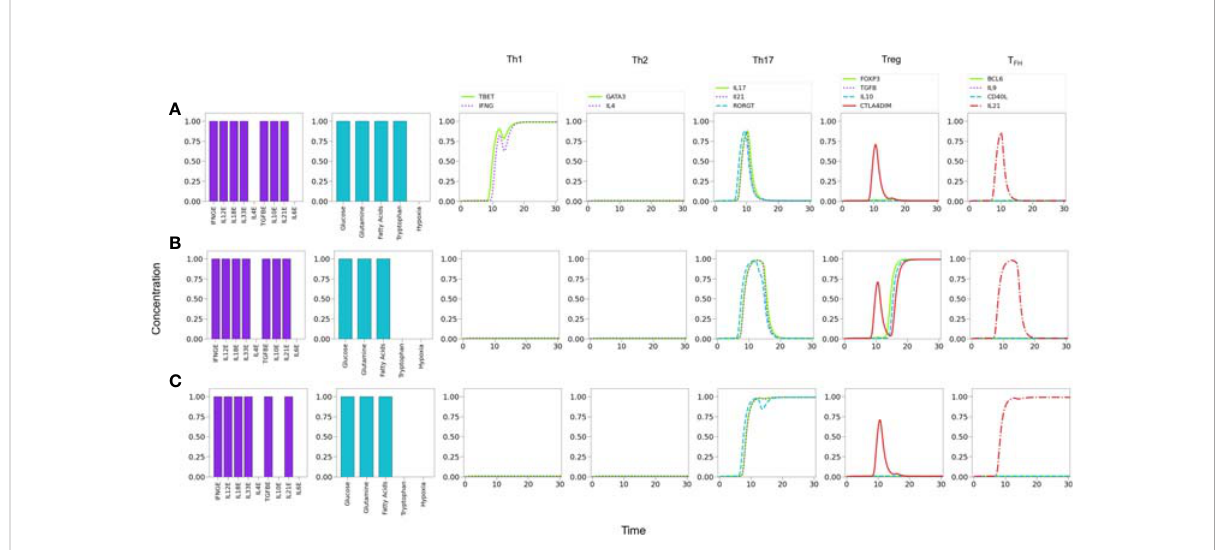
FIGURE 9 Effects of tryptophan de fi ciency in a microenvironment de fi ned by Th1-, Th17- and Treg-inducing cytokines in absence of exogenous IL-4 and IL-6. (A) Optimal tryptophan levels induce a Th1 phenotype, with transient expression of Th17 traits. (B) Tryptophan de fi ciency inhibits Th1 expression, allowing the emergence of Treg polarization due to the activity of exogenous TGF- b and IL-10. An increased transient expression of Th17 is also observed. (C) Tryptophan de fi ciency, along with the absence of exogenous IL-10, depletes Treg and allows steady Th17 polarization due to the action of